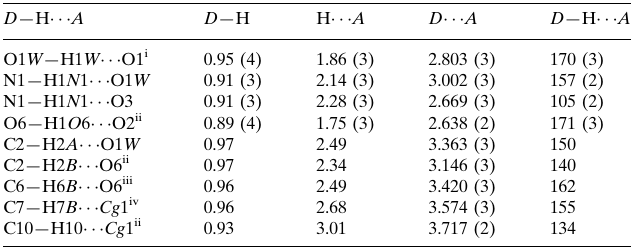
9426 measured reflections 2248 independent reflections 1884 reflections with I > 2 (cid:1) ( I ) R int = 0.035 H atoms treated by a mixture of independent and constrained